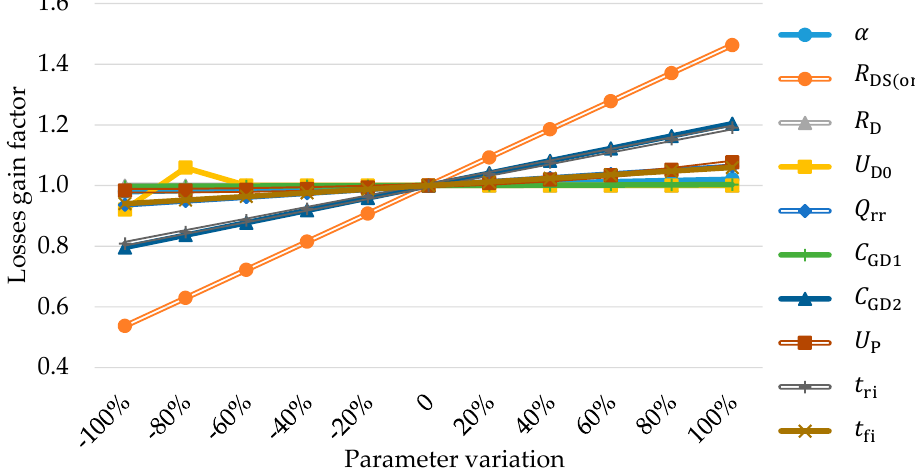
Figure 4. Sensitivity analysis of losses against switch parameters.